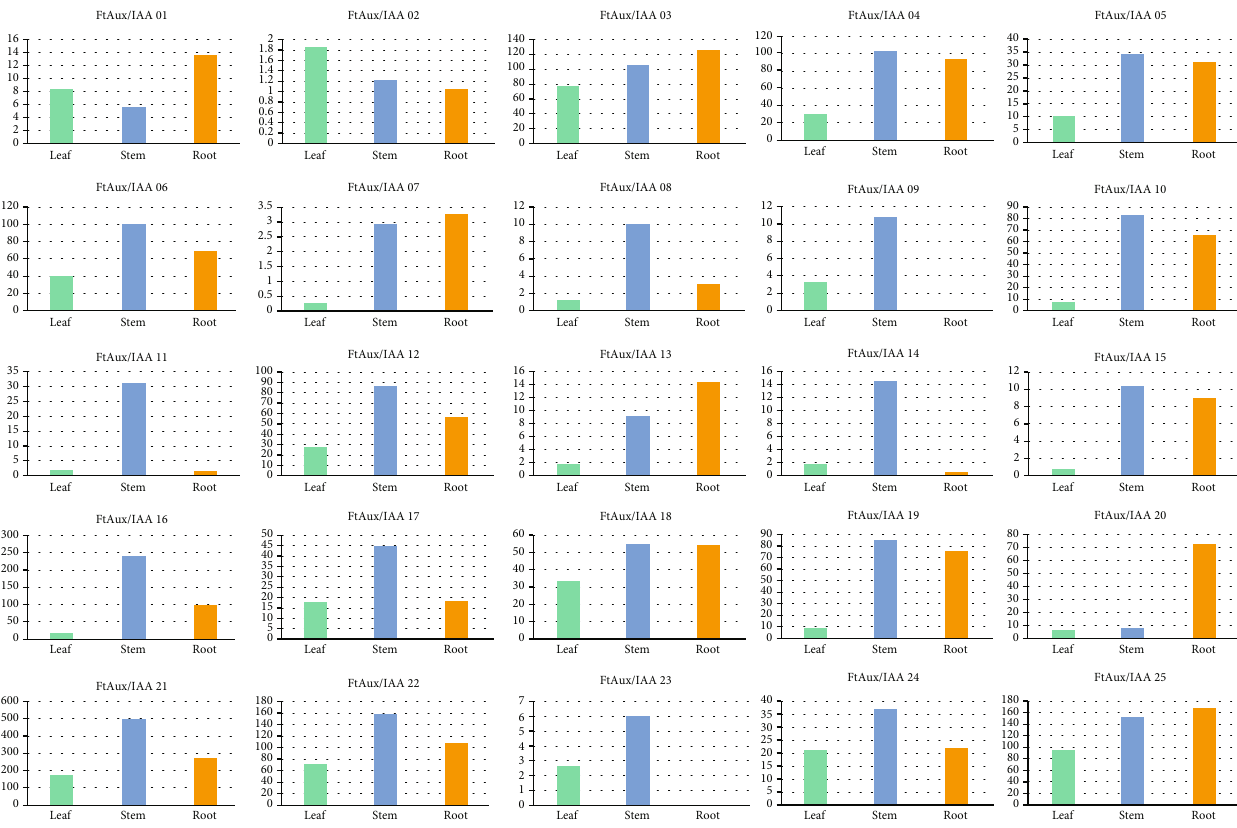
Figure 5: Expression of FtAux/IAA genes in di ff erent tissues from Tartary buckwheat. qRT-PCR was used to assess FtAux/IAA gene transcript levels in total RNA samples extracted from the leaves, stems, and roots of seeding plants at the two-leaf